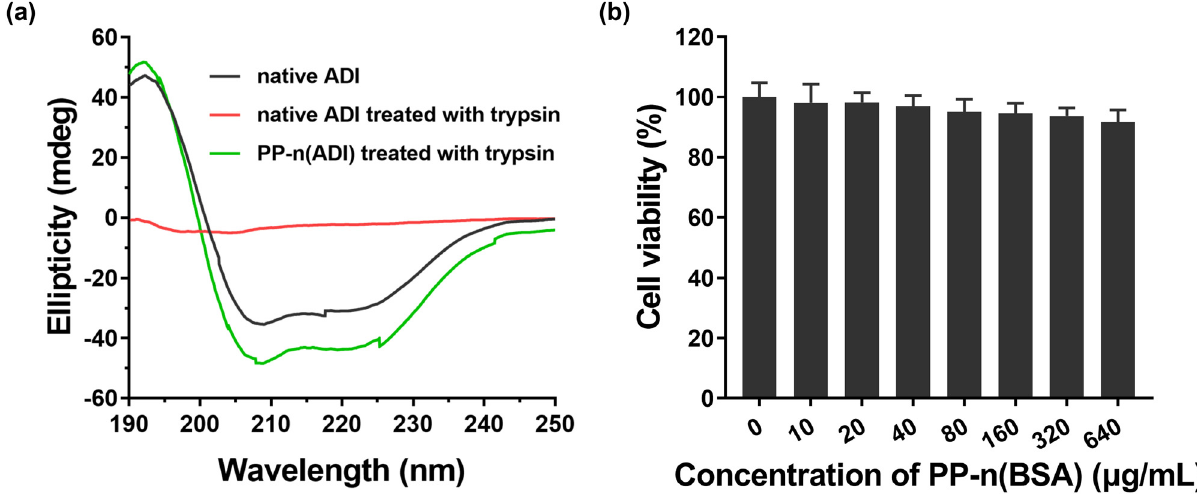
Figure 6: ( a ) CD analysis of native ADI, native ADI treated with trypsin, and PP - n ( ADI ) treated with trypsin. ( b ) Cytotoxicity of di ff erent concentrations of PP - n ( BSA ) in